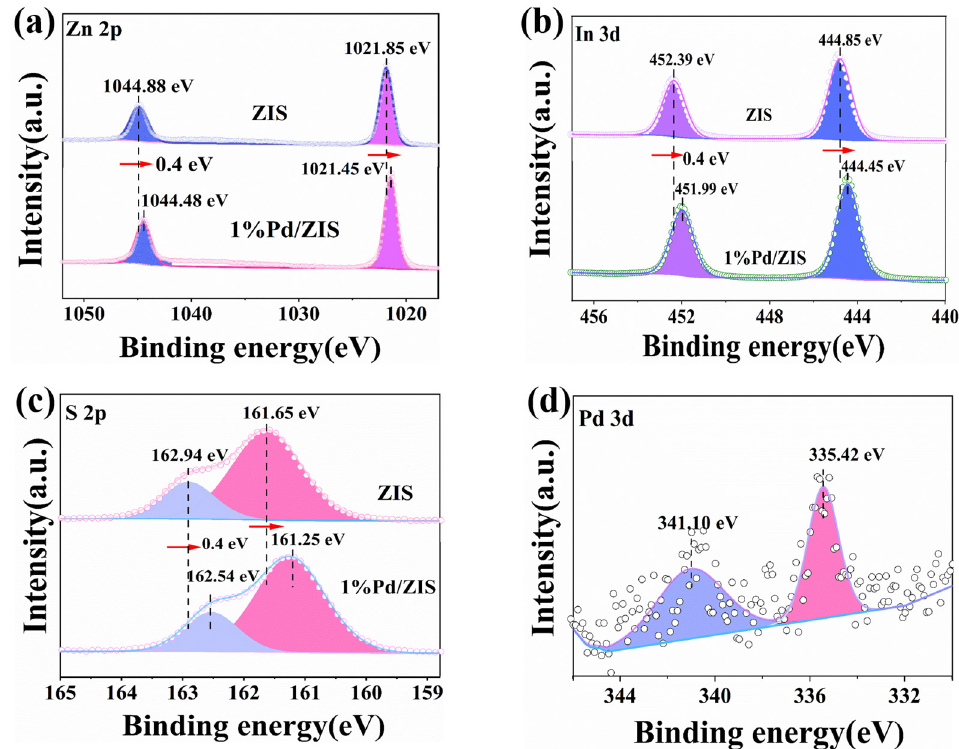
Figure 3. XPS spectra of ZIS and 1% Pd/ZIS: ( a ) Zn 2p; ( b ) In 3d; ( c ) S 2p; ( d ) Pd 3d.